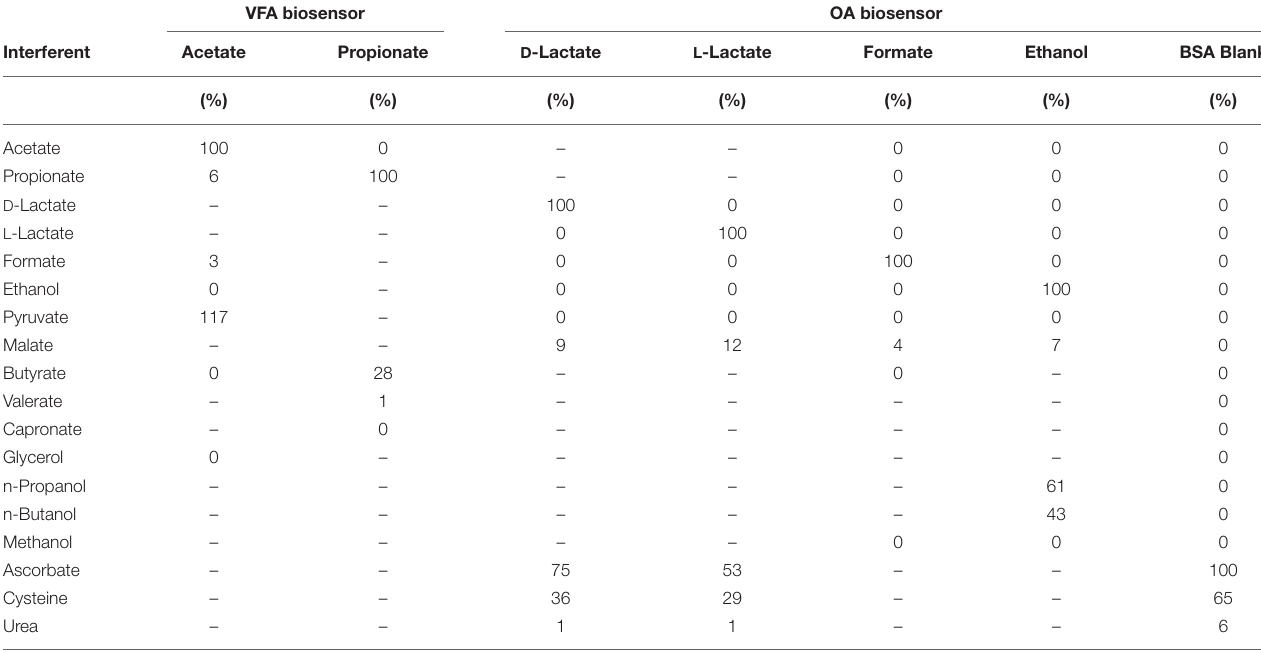
TABLE 2 | Effect of potential interferents on the different electrodes of the volatile fatty acid (VFA) and organic acid (OA) biosensor. VFA biosensor OA biosensor Interferent Acetate